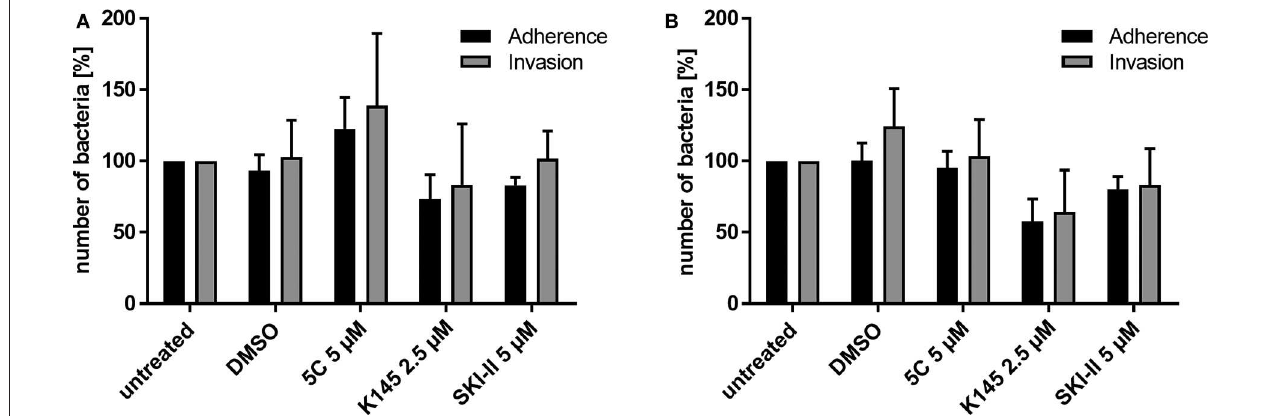
FIGURE 2 | Differential immunofluorescence staining to distinguish between extra- (adherent) and intracellular (invasive) Neisseria N927 in Chang cells. Treatment with SphK inhibitors and infection with N927 was performed as for the gentamicin protection assay. First, extracellular bacteria were immunolabeled with anti-gonococcal antibody and secondary antibody Cy5, both incubated for 1h each, before permeabilization of the cells with 0.1% Triton for 15min and blocking with BSA. Then, a second anti-gonococcal antibody was added for 1h and labeled with Cy2 conjugated secondary antibody for another 1h. The quantification of the immunofluorescence was done either by manually counting (A) or by using an automated microscope (Operetta) system (B) . Error bars show the mean ± SD of three independent